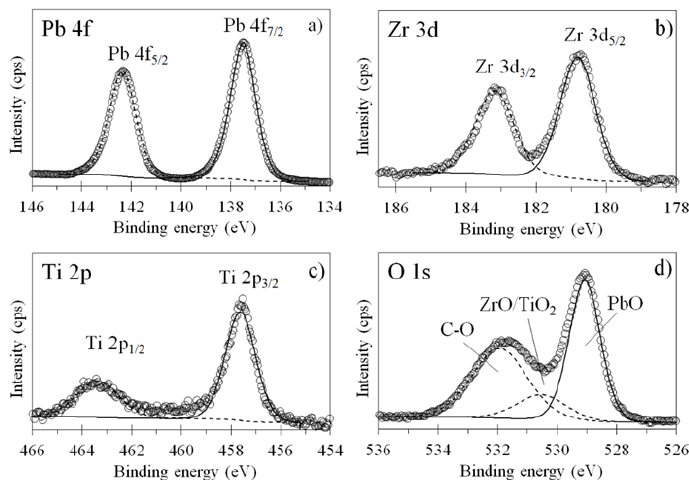
Figure 7. High-resolution XPS spectra deconvolution for the ( a ) Pb 4f; ( b ) Zr 3d; ( c ) Ti 2p; ( d ) O 1s regions of the PZT thin films deposited at 550 °C substrate temperature.